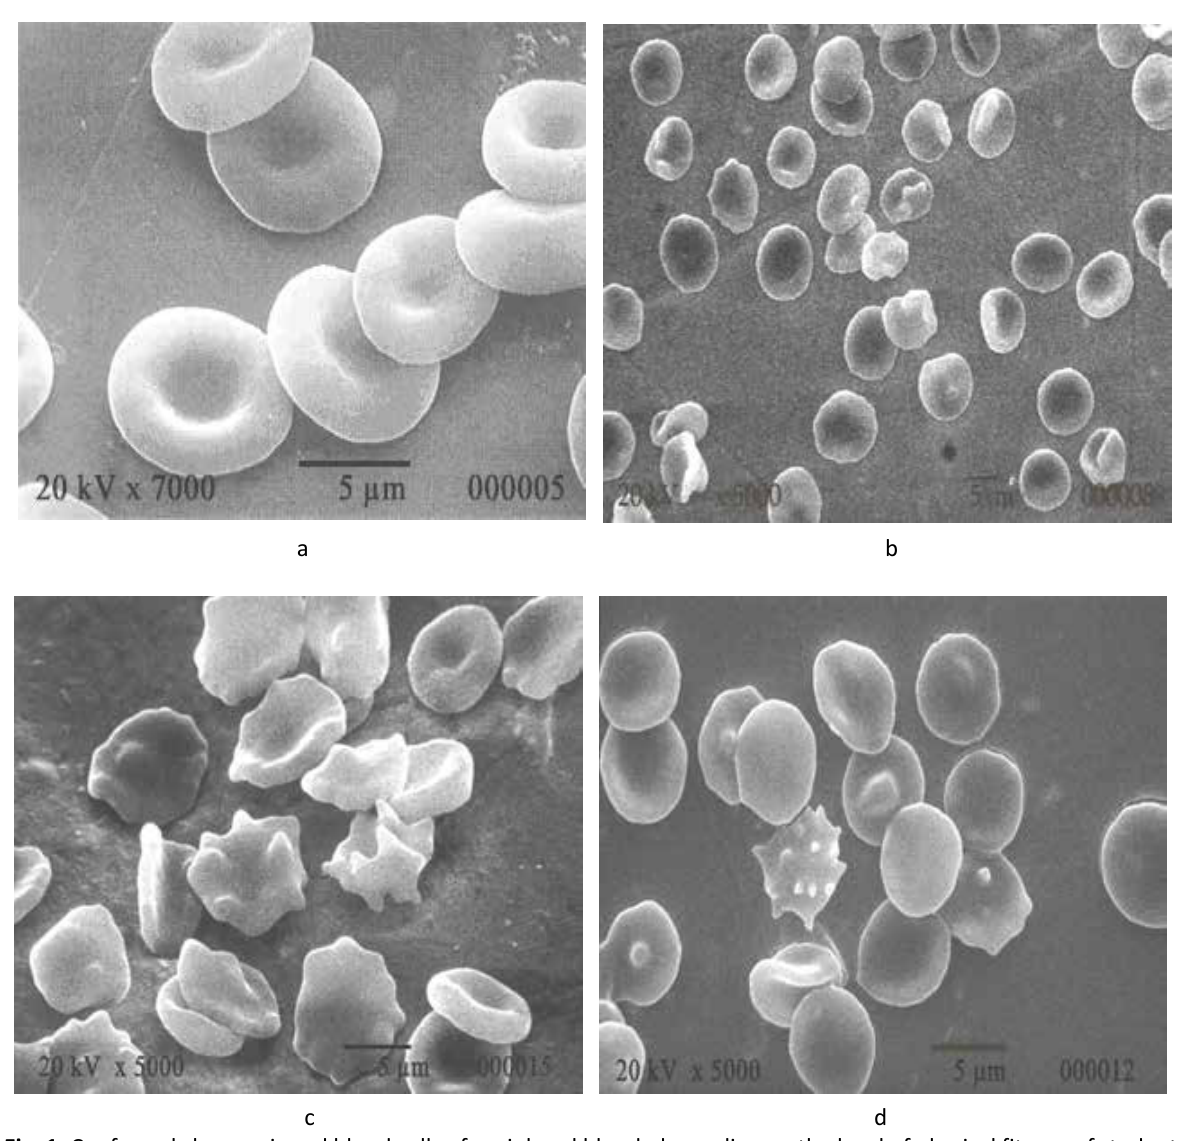
Fig. 1. Conformal changes in red blood cells of peripheral blood, depending on the level of physical fitness of students in performing the shuttle run test (12-min run in 20 m): a – above the average, b – average, c – lower than average, d – low level of physical fitness . Method: scanning